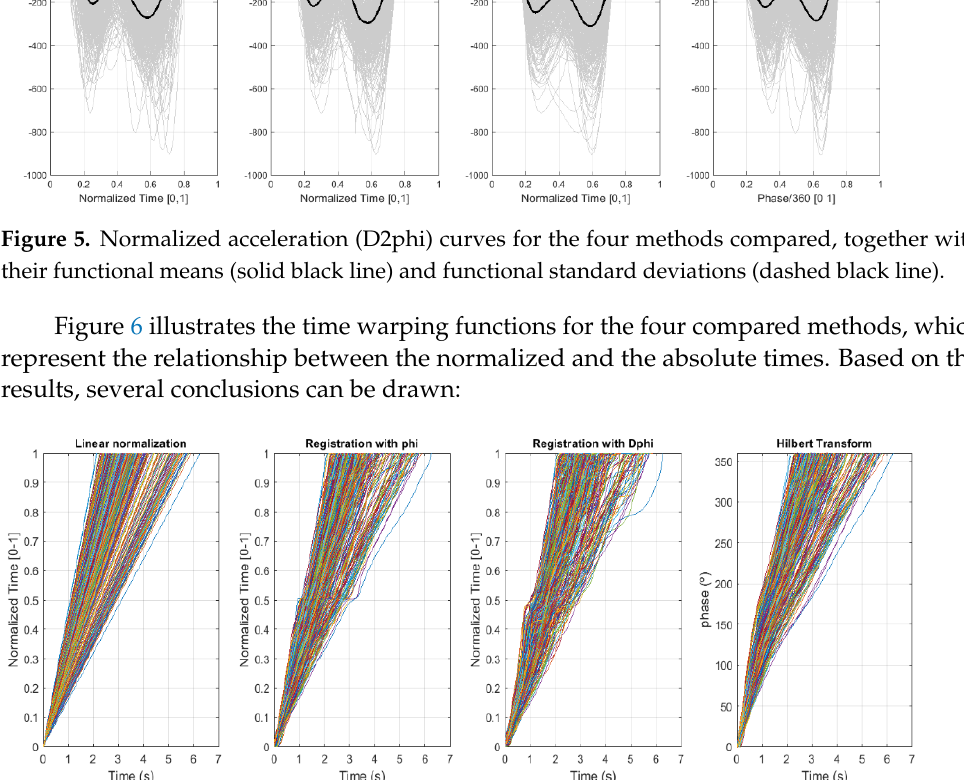
Figure 6. Time warping functions for the four methods compared. To better appreciate the detail of the warping functions, only a quarter of the curves used in the analysis have been drawn (the same ones represented in Figure 2).